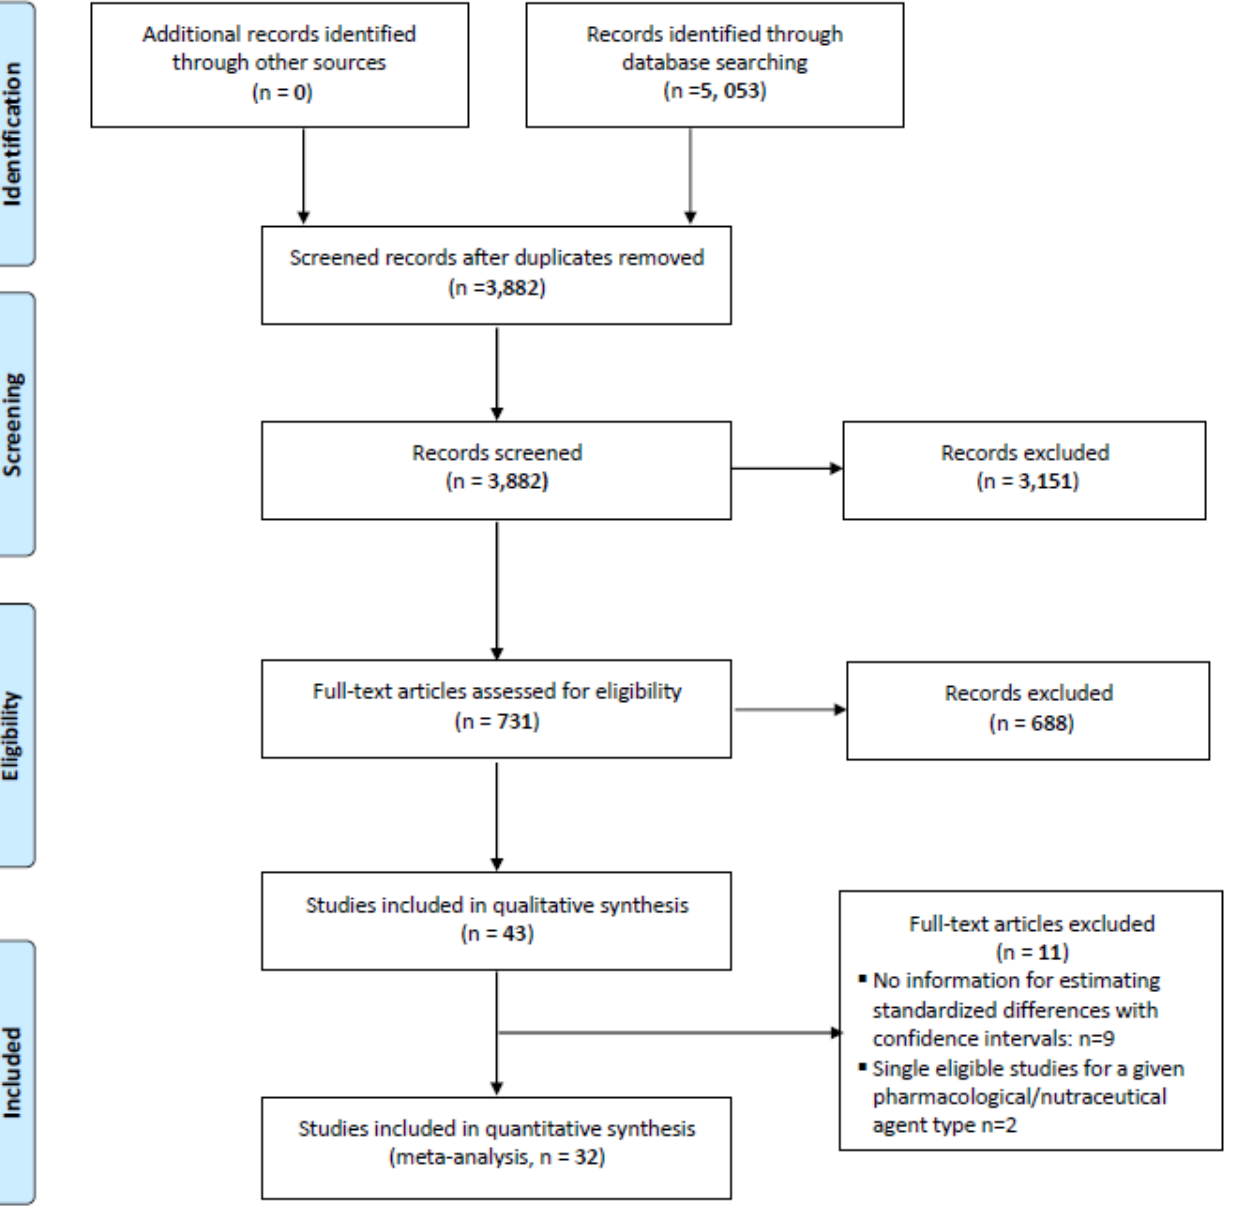
Figure 1. PRISMA FLOW DIAGRAM.